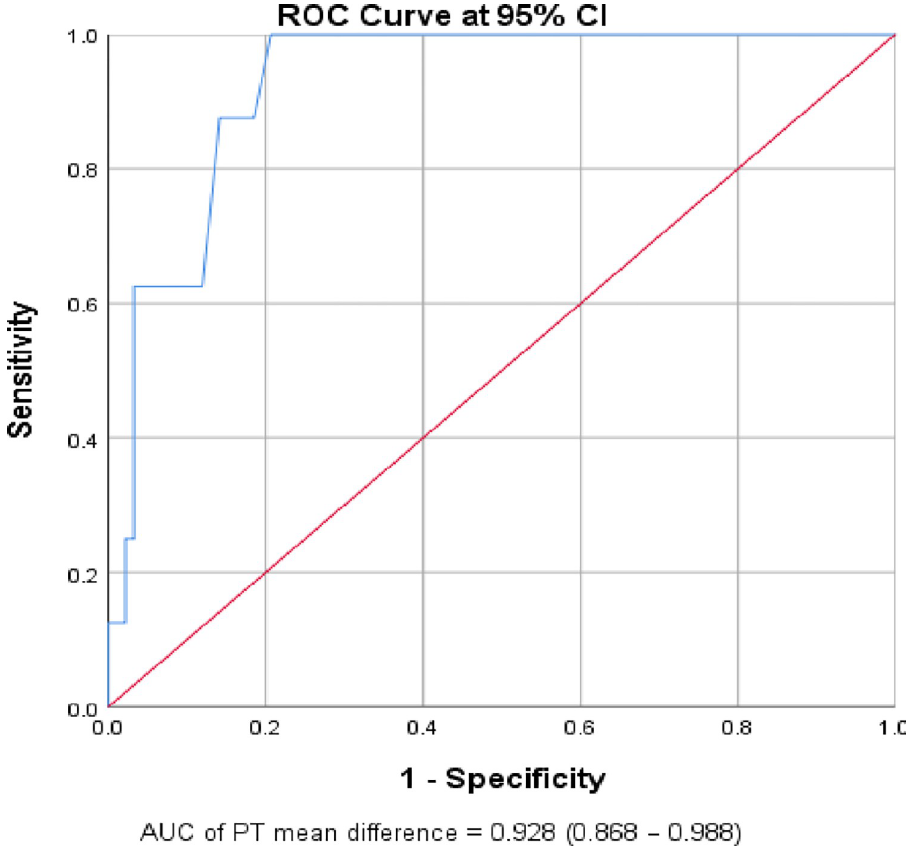
Fig 2. The ROC curve of the gradual change of prothrombin time over the 7th days for prediction of worse prognosis (n = 100).